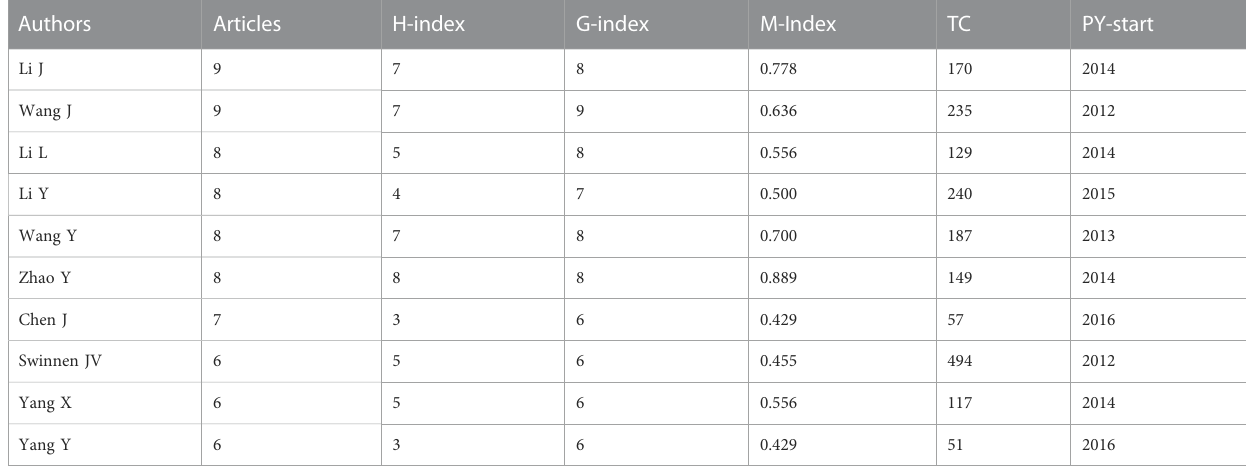
TABLE 5 Publication and impact of the top ten authors by the number of articles.